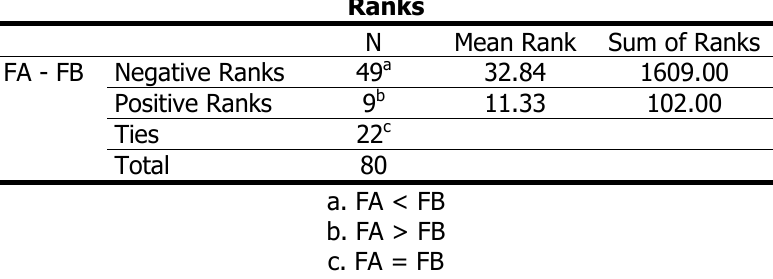
Table 11. Wilcoxon Signed Ranks Fantasy Motivation